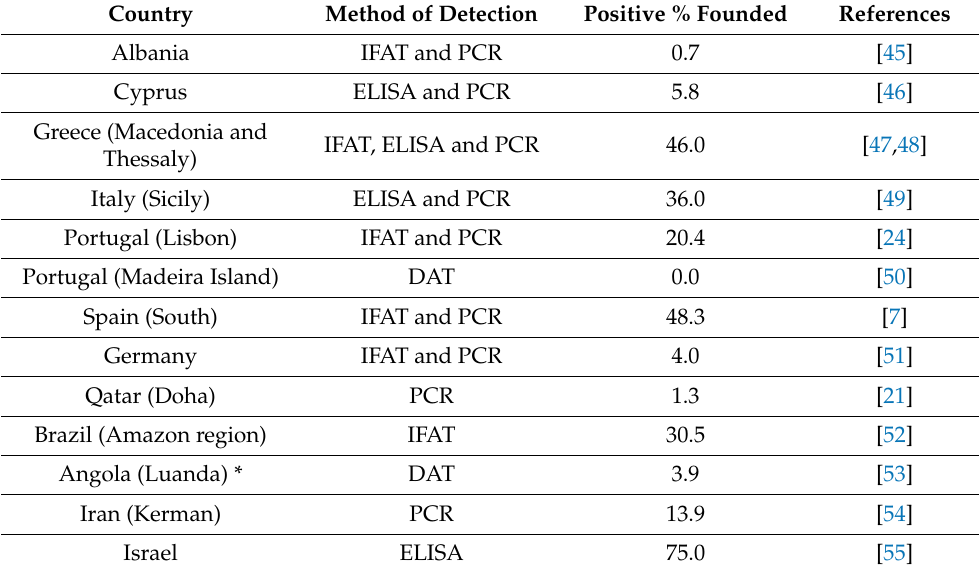
Table 1. Countries where high positive percentage of cases of L. infantum infection in cats have been reported and detection method (IFAT: immunofluorescence antibody test; DAT: direct agglutination test; PCR: polymerase chain reaction; ELISA: enzyme-linked immunosorbent assay). The material analyzed was serum samples for IFAT and ELISA tests, and whole blood for PCR test. * In this study, the authors analyze the antibodies to Leishmania spp.